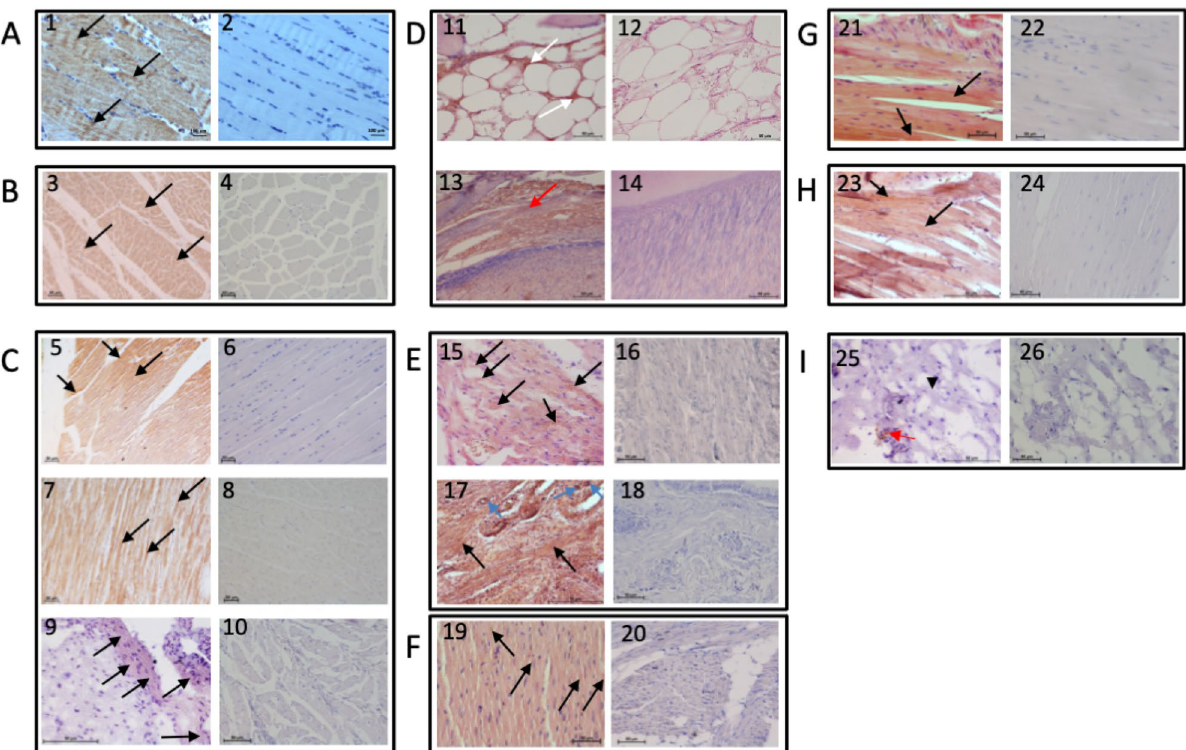
in addition to the monoclonal antibodies anti-MAGE/10 (odd numbers) or with H&E only (even numbers). The representative pictures of human skeletal muscles (1, 2), horse skeletal muscles (3, 4), pig skeletal muscles (5, 6), pig heart (7, 8), pig intestinal smooth muscles (9, 10), rabbit adipose tissue (11, 12), rabbit connective tissue (13, 14), rat heart (15, 16), rat intestinal smooth muscles (17, 18), chicken heart (19, 20), frog skeletal muscles (21, 22), fish skeletal muscles (23, 24), snail muscle tissue (25, 26) are shown. Black arrows show positive staining of skeletal (1, 3, 5, 21, 23), heart (7, 15, 19) and smooth muscle (9, 17, 25) myocytes; black arrowhead shows negative staining of smooth muscle myocytes (25); blue arrows show positive staining of arterial myocytes (17); red arrows show positive staining of connective tissue (13, 25); white arrows show positive staining of adipose tissue (11). The scale bars show 50